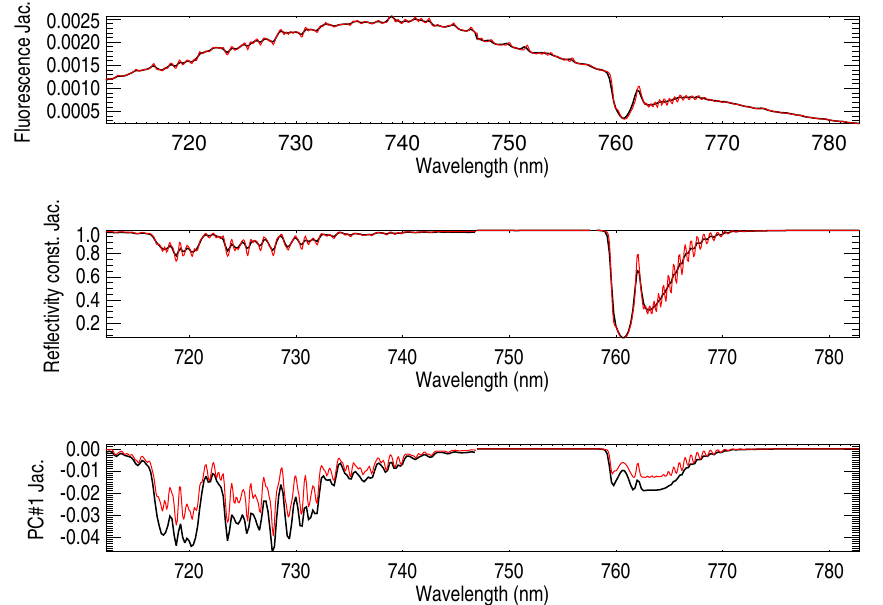
Fig. 10. Typical Jacobians ( ∂ρ/∂x ) where x is the far-red fluorescence peak value (top), the wavelength-independent component of the surface reflectivity (middle), and the coefficient of the first PC (bottom) for FWHM = 0.5nm (black) and FWHM = 0.3nm (red). The PC analyses are carried out separately for the wavelength ranges 712–747nm and 747–783nm but are shown in a single plot for convenience.